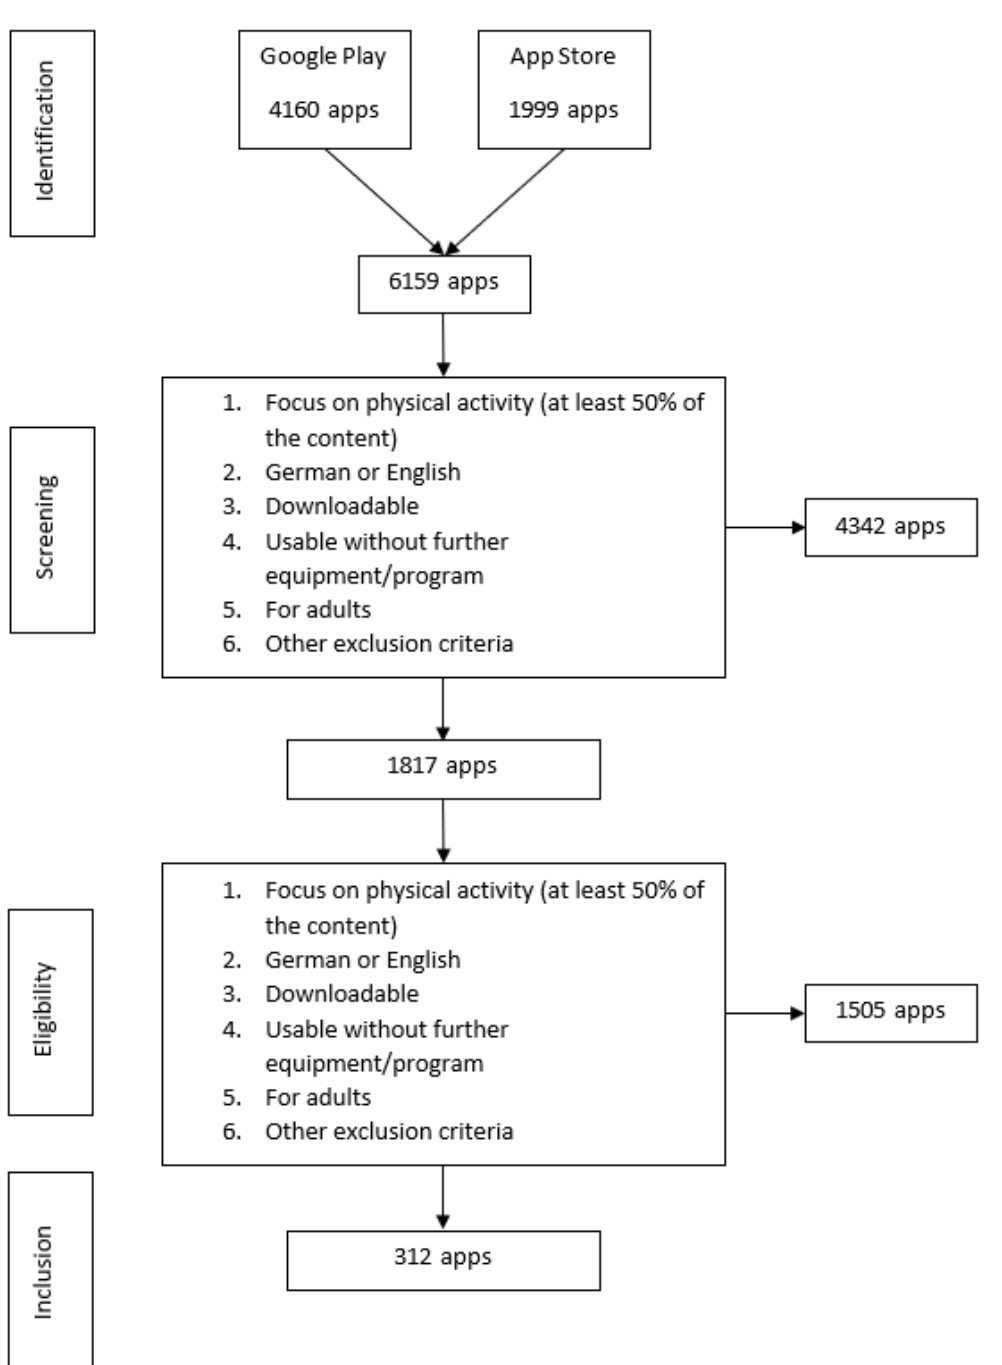
Figure 1. Flowchart of the inclusion and exclusion